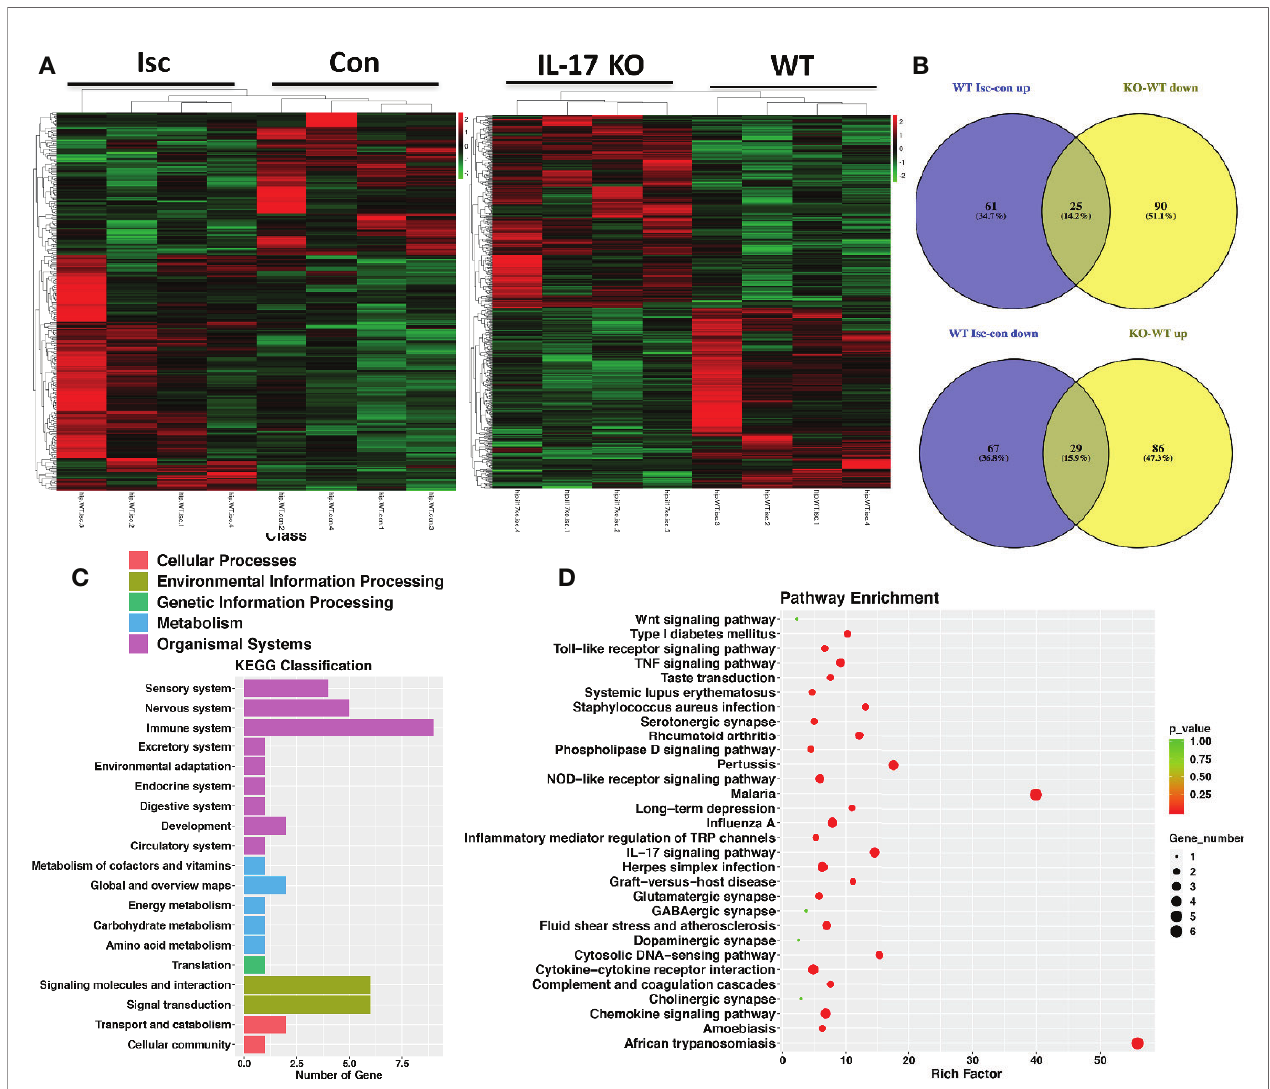
FIGURE 4 | IL-17 could regulate Wnt pathway and synapses in the nervous system. (A) Transcriptome pro fi les from ischemic and contralateral hippocampus of WT mice and ischemic hippocampus from IL-17 KO and WT mice, respectively. Bands with red, black, or green in the heat map indicated high, moderate, or low expression, respectively. (B) The Venn diagram of DEGs by performing ischemic injury and knocking out IL-17. 25 genes were upregulated by performing ischemia but downregulated by knocking out IL-17, while 29 genes downregulated by performing ischemia but upregulated by knocking out IL-17. (C) The KEGG classi fi cation analysis showed DEGs in ischemic hippocampus between IL-17 KO and WT mice were closely related to the nervous and immune systems. (D) The pathway enrichment analysis indicated the DEGs between IL-17 KO and WT mice were involved in the regulation of Wnt and IL-17 pathways, as well as variety synapses. Isc, ischemic hippocampus; Con, contralateral hippocampus; IL, interleukin; KO, knockout; WT, wild type; DEGs, differentially expressed genes; KEGG, Kyoto Encyclopedia of Genes and